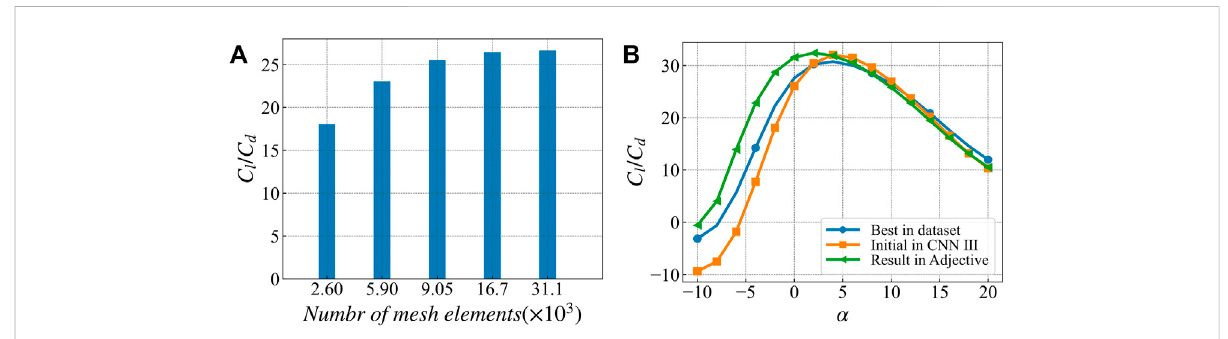
FIGURE 14 Veri fi cation of lift-drag ratio based on CFD optimization results. (A) Calculation results of lift drag ratio of the best airfoil in the database at 0 ° angle of attack with different grid numbers (B) lift drag ratio curves of the best airfoil, initial airfoil and optimized airfoil in the database.